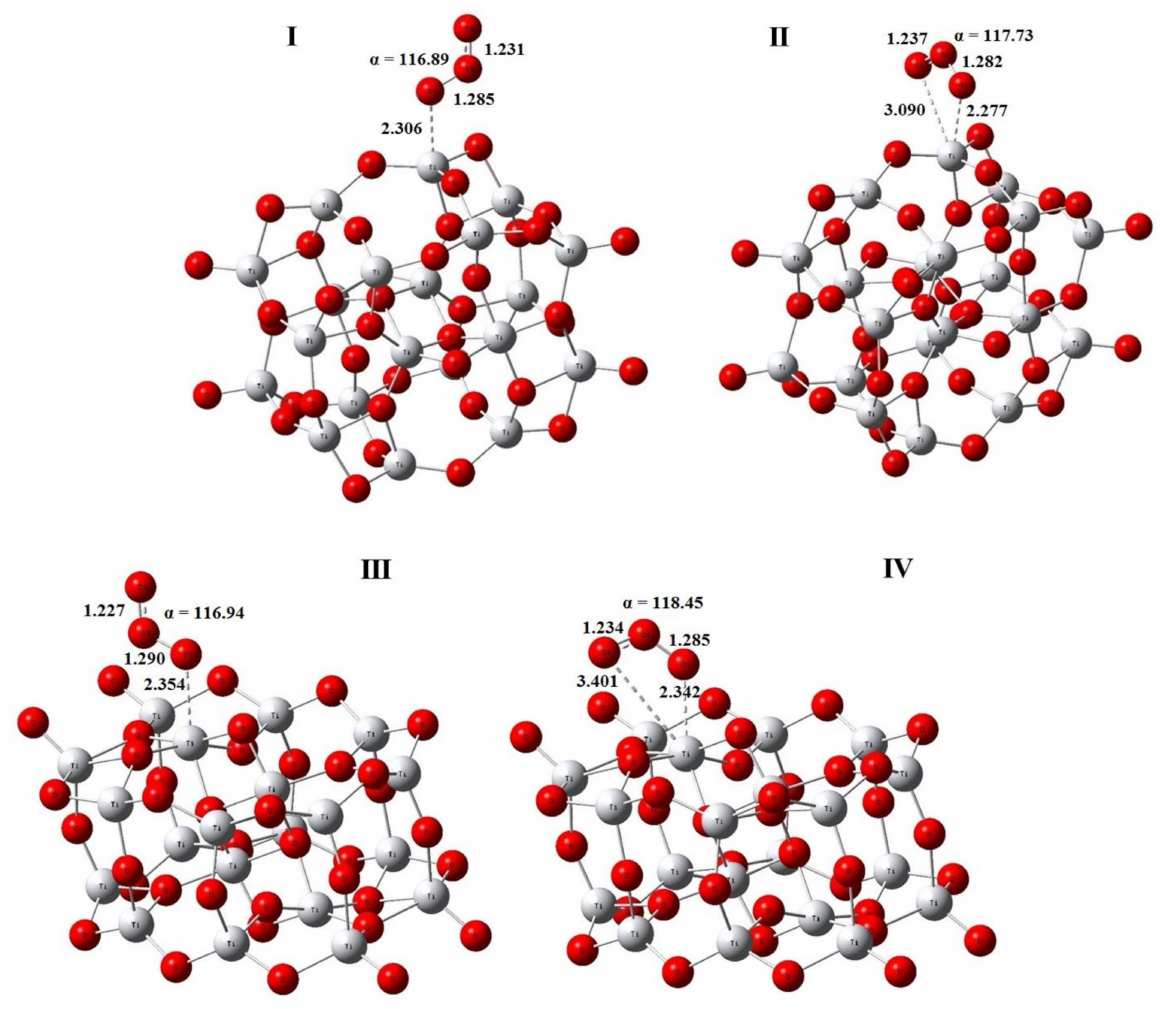
Figure 6. The optimized geometry of the monodentate ( I ) and bidentate ( II ) ozone complexes on the 4-coordinated Ti 4+ ions, and of the monodentate ( III ) and bidentate ( IV ) complexes with 5-coordinated Ti 4+ ions of the anatase cluster Ti 20 O 40